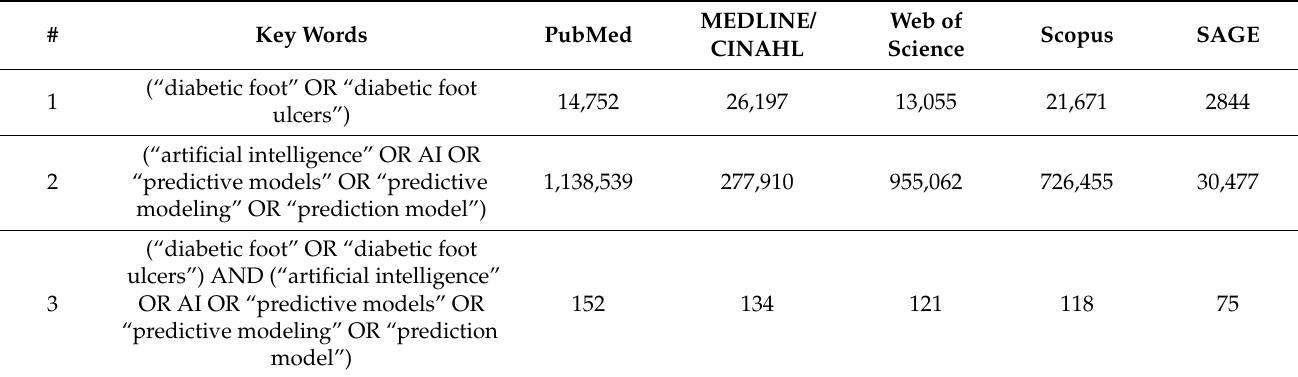
Table 1. Searches in the